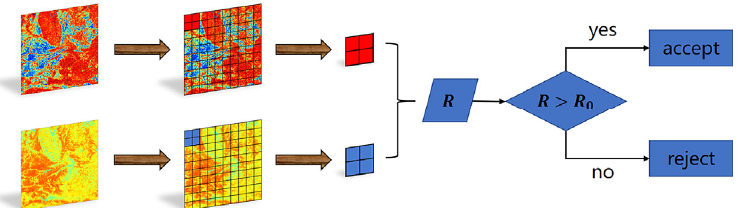
Figure 2. Schematic diagram of the proposed sampling procedure. (cid:1844) is the correlation coefficient between the two windows. (cid:1844) (cid:2868) is the preset threshold.